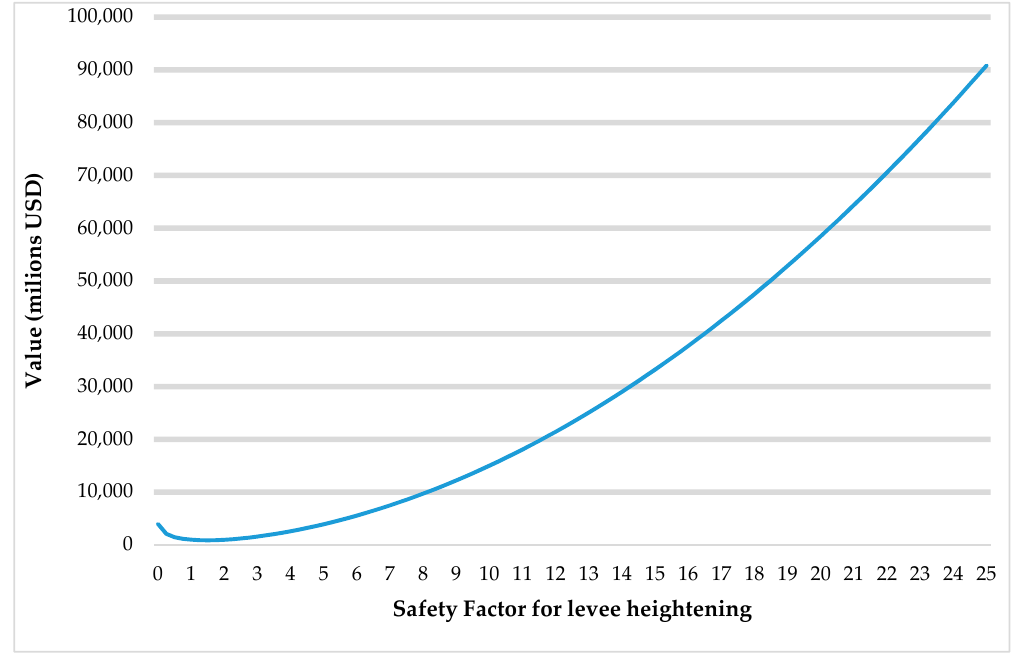
Figure 9. Objective function for the high value case depending on 𝜺 𝑻 when υ = 0 .